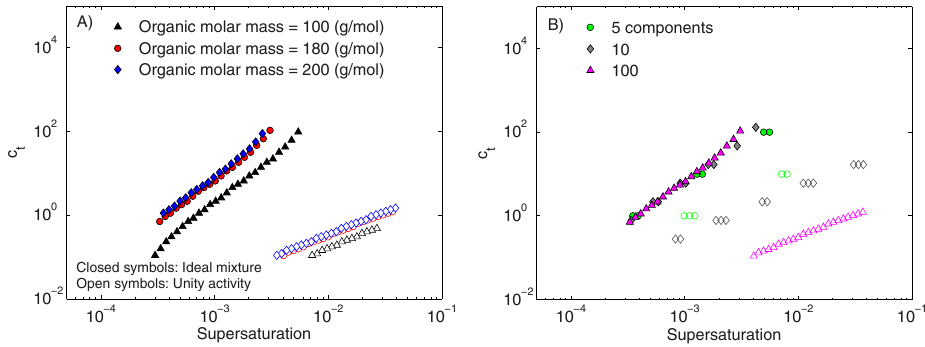
Figure 10. Sensitivity of the c t values to supersaturation, molar mass and number of components for distribution 1 with the mid solubility range (see Table 2). Only points with limited solubility (0< ε <1) at the point of activation are